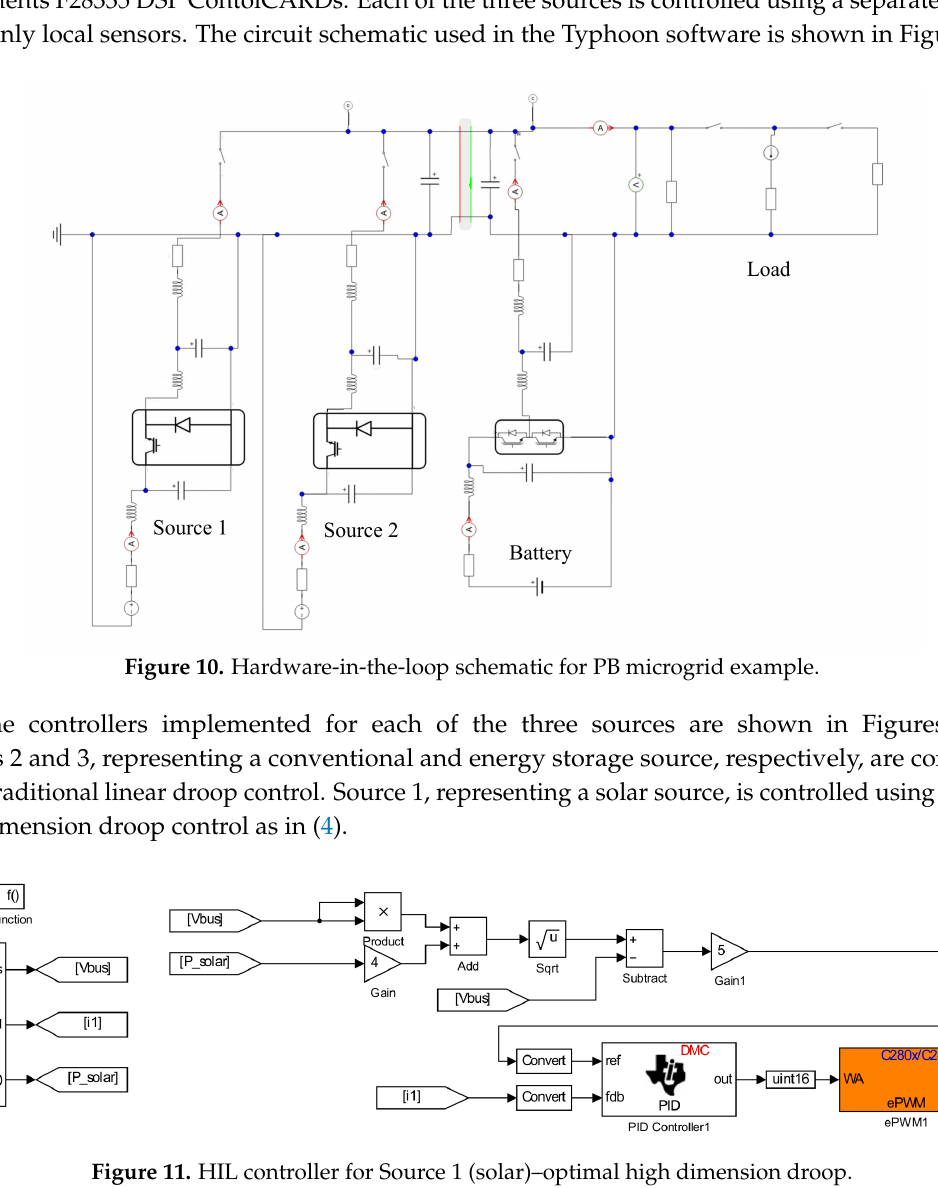
Figure 11. HIL controller for Source 1 (solar)–optimal high dimension droop.